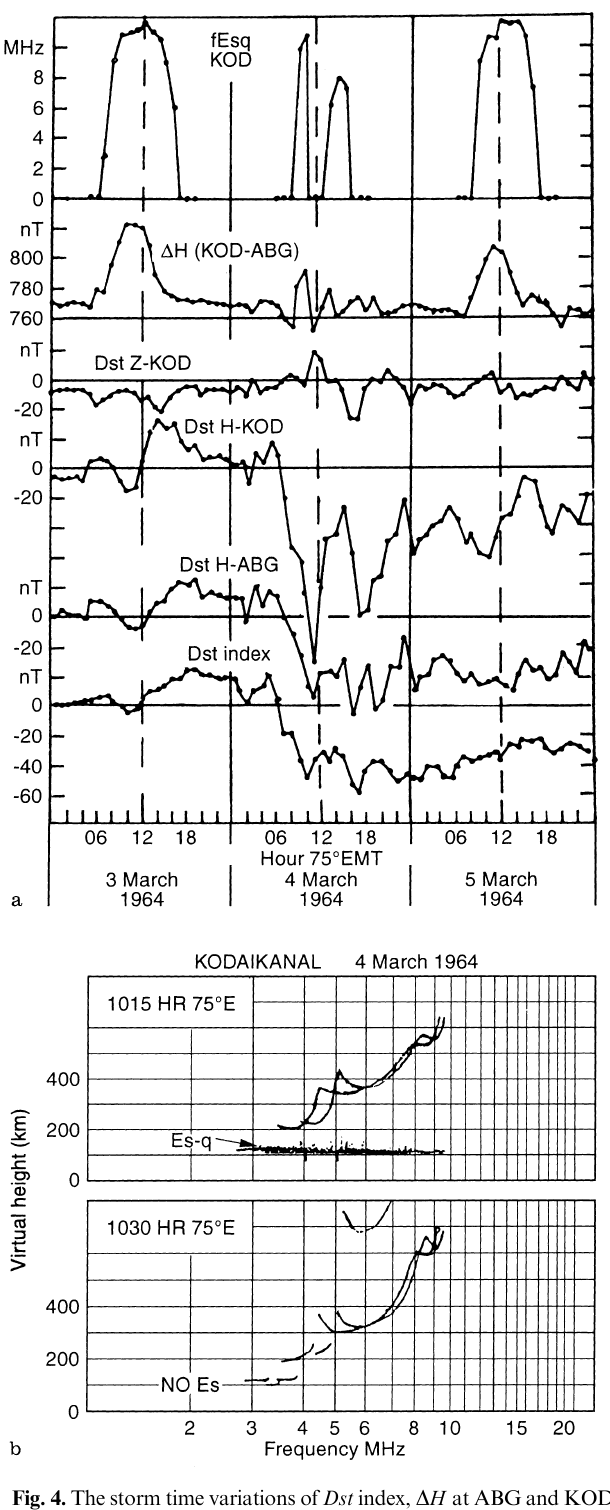
Fig. 4. The storm time variations of Dst index, (cid:68) H at ABG and KOD, (cid:68) Z at KOD, (cid:68) H (KOD-ABG) and the maximum frequency reflected from the ionosphere ( fEsq ) over Kodaikanal during the GC type geomagnetic storm starting at 1820 h on 3 March 1964; b ionograms at Kodaikanal on 4 March 1964 showing the presence of E s - q echoes at 1015 h, 75 (cid:14) E and complete absence of E s - q echoes at